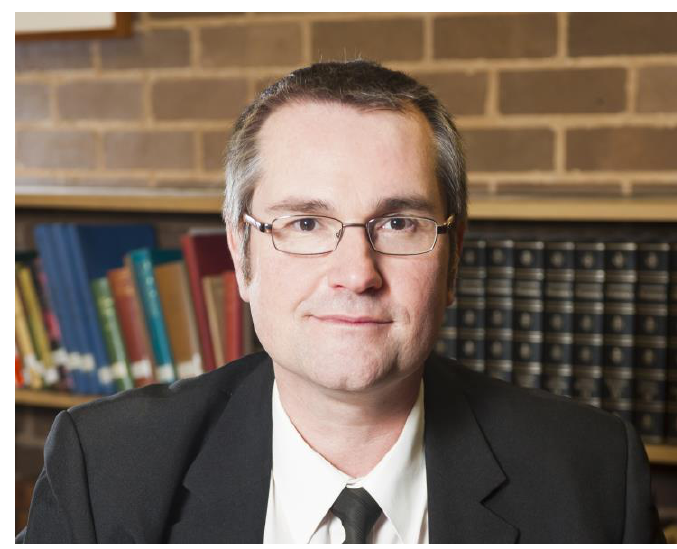
Figure A2. Craig T. Simmons.